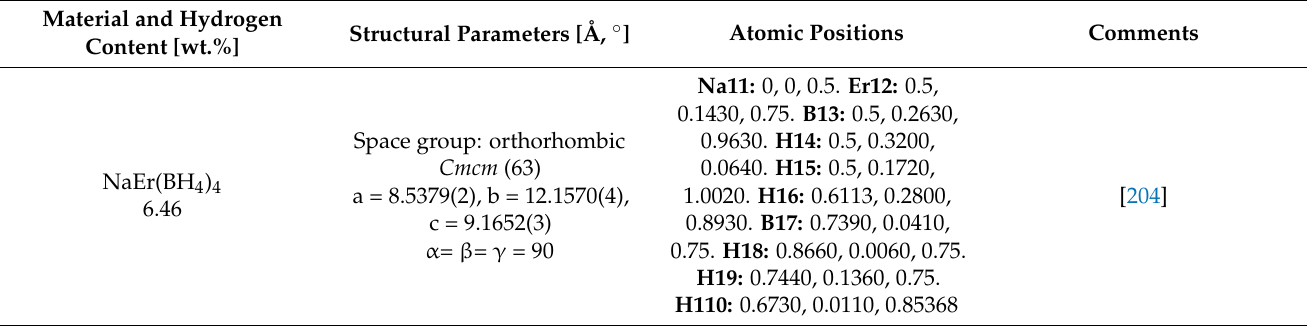
Table 16. Crystal structures of Er-borohydrides.